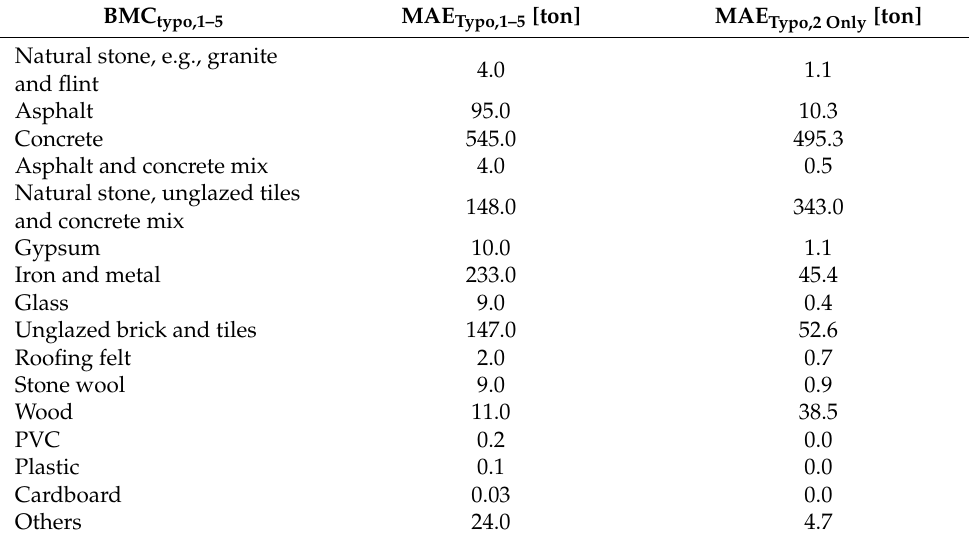
Table 4. Post demolition BMC model and its